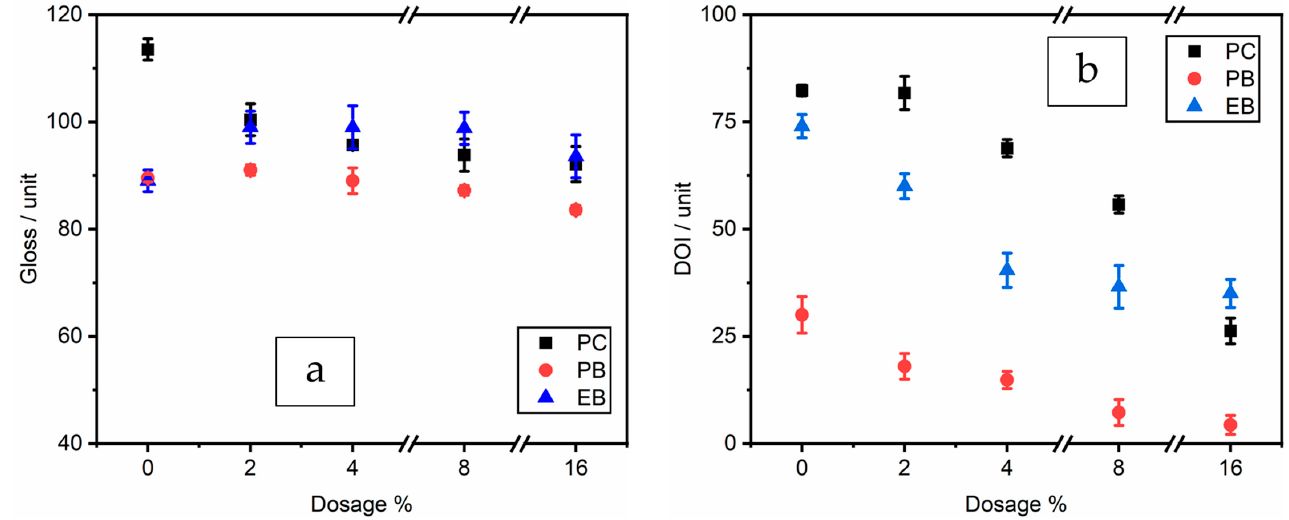
Figure 1. Gloss ( a ) and DOI ( b ) values of ZP in PC, PB, and